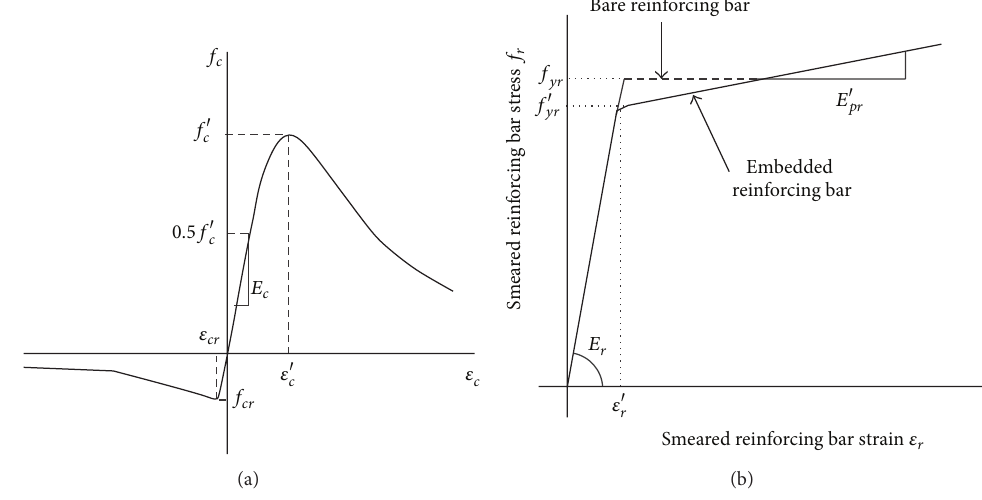
Figure 12: Material models: (a) concrete and (b) reinforcing